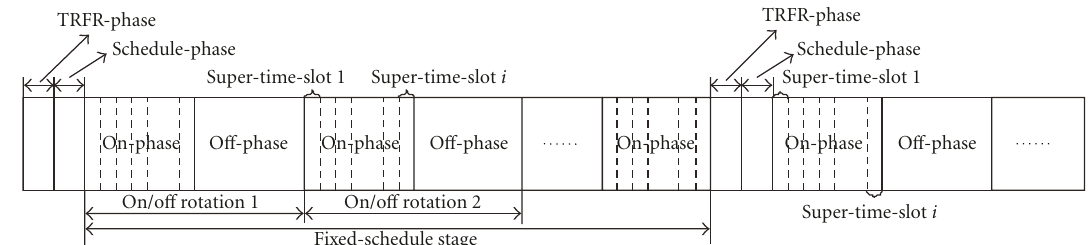
Figure 2: System time scheme structure.